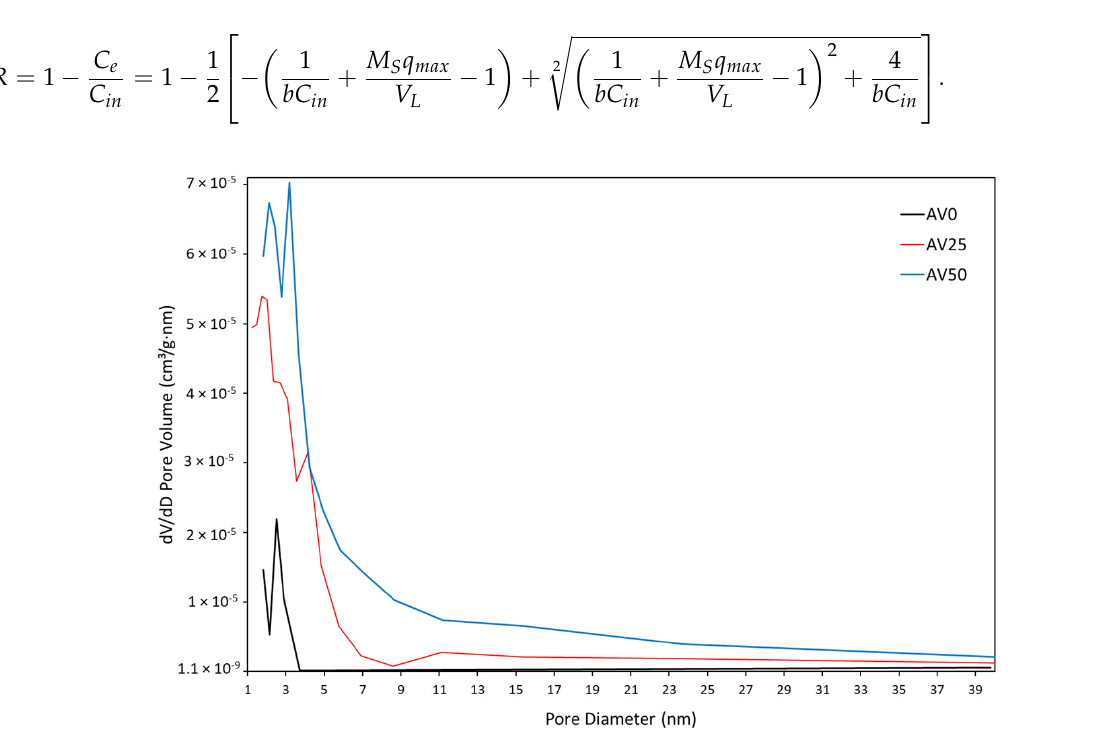
Figure 5. Relation between pore volume and diameter for AV0, AV25, and AV50.